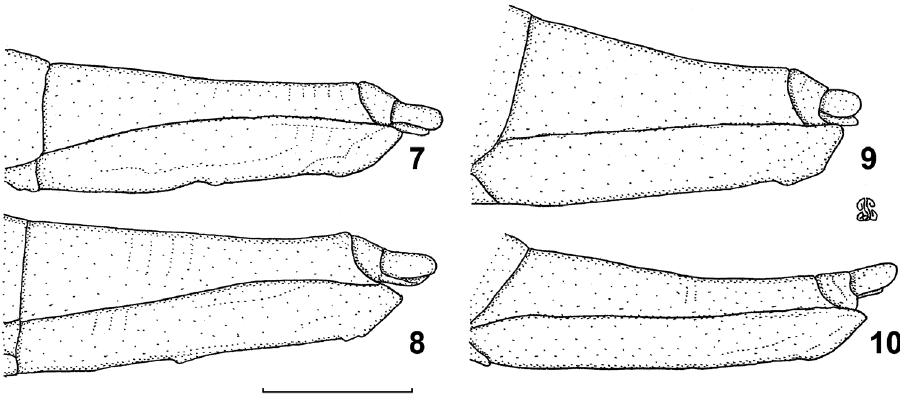
Figures 7–10. Gibbasilus species ♀ ovipositors. 7 G. arenaceus Londt, 1986 8 G. centrolobus Londt, 1990 9 G. condylus sp. n. 10 G. crinitus sp. n.